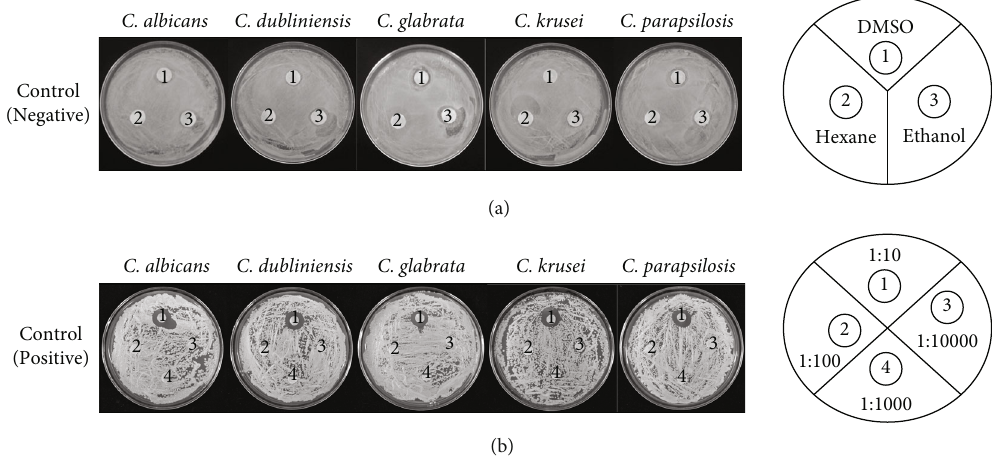
Figure 1: Susceptibility assays with the solvents used to obtain the P. tithymaloides , T. vulgaris , or O. basilicum